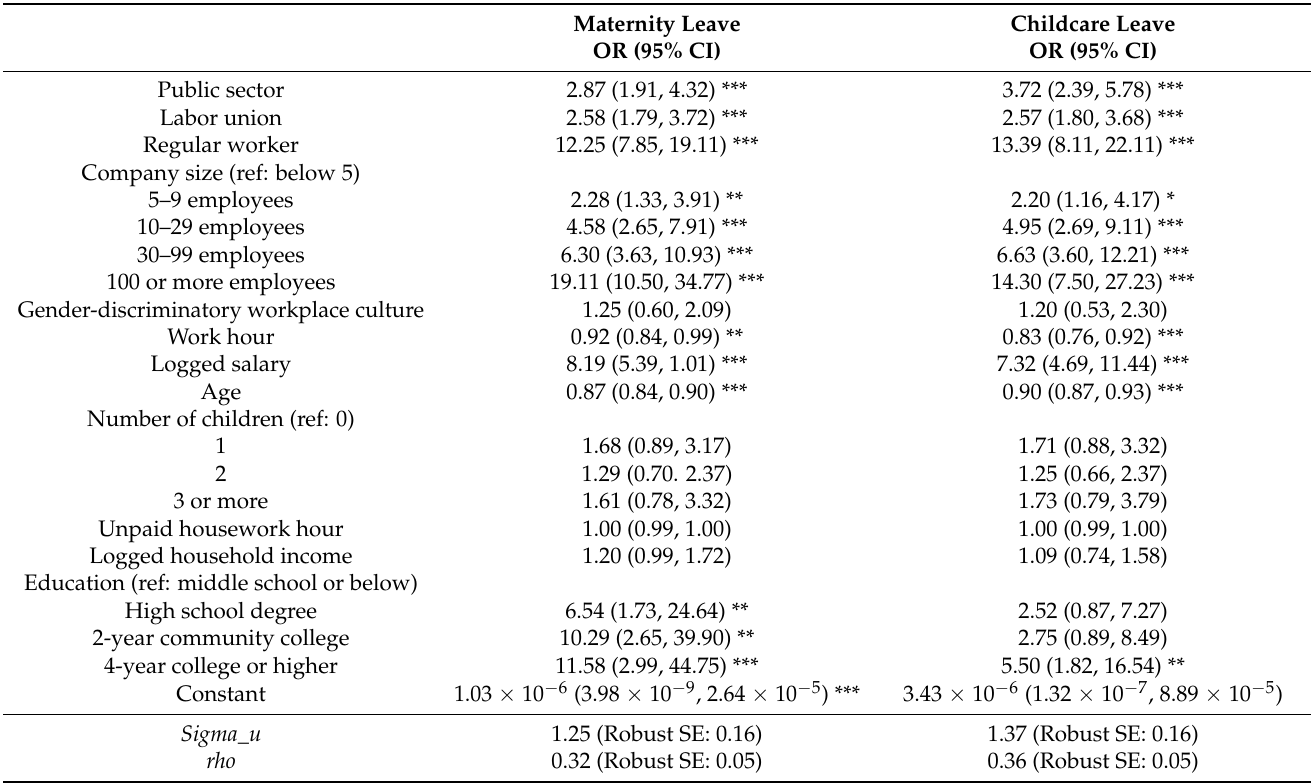
Table 4. Multivariate logistic random effects model for determinants of leave accessibility. Maternity Leave Childcare Leave OR (95%